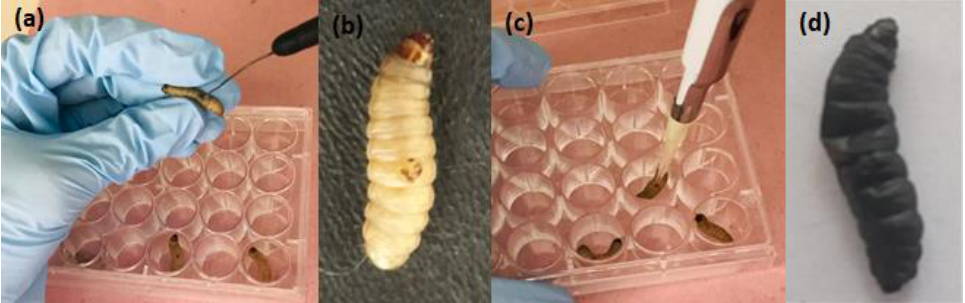
Figure 3. Burn infection model in G. mellonella . Larvae were injured with a heated steel instrument in their cuticle ( a ), resulting in a burn lesion ( b ). After larvae were locally infected with a suspension of A. baumannii ( c ), it was possible to observe the progression of systemic infection ( d ).